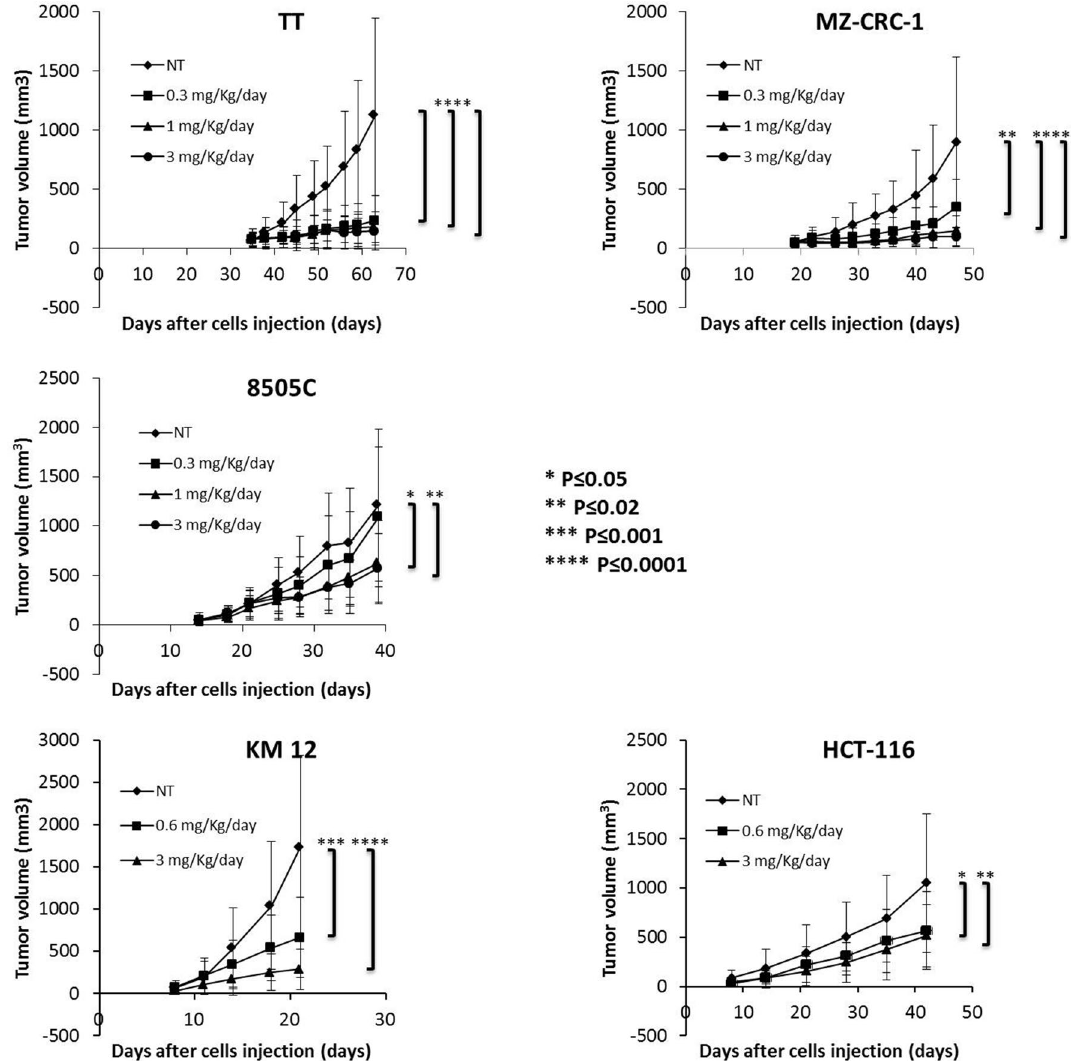
Figure 5. The indicated human cancer cell lines were inoculated subcutaneously into both flanks of either SCID (TT, MZ-CRC-1 and 8505C) or nu/nu (KM12 and HCT-116) mice. When tumours were visible, animals were randomly assigned to receive Pz-1 or vehicle for the indicated time points by oral gavage. Average size ± SD of tumours is